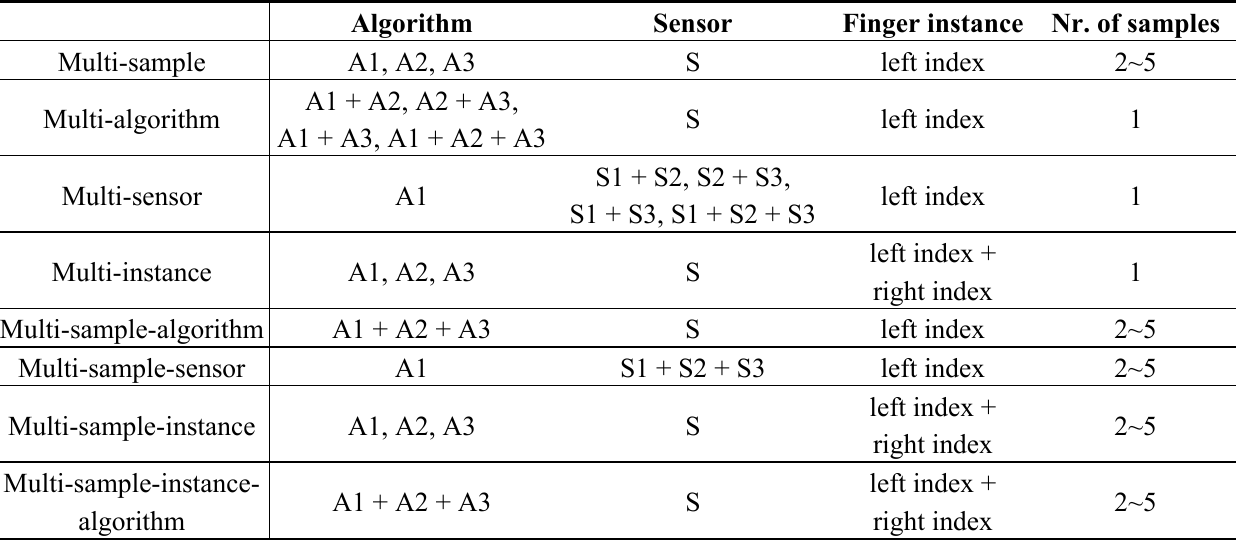
Table 2. Special settings for different fusion